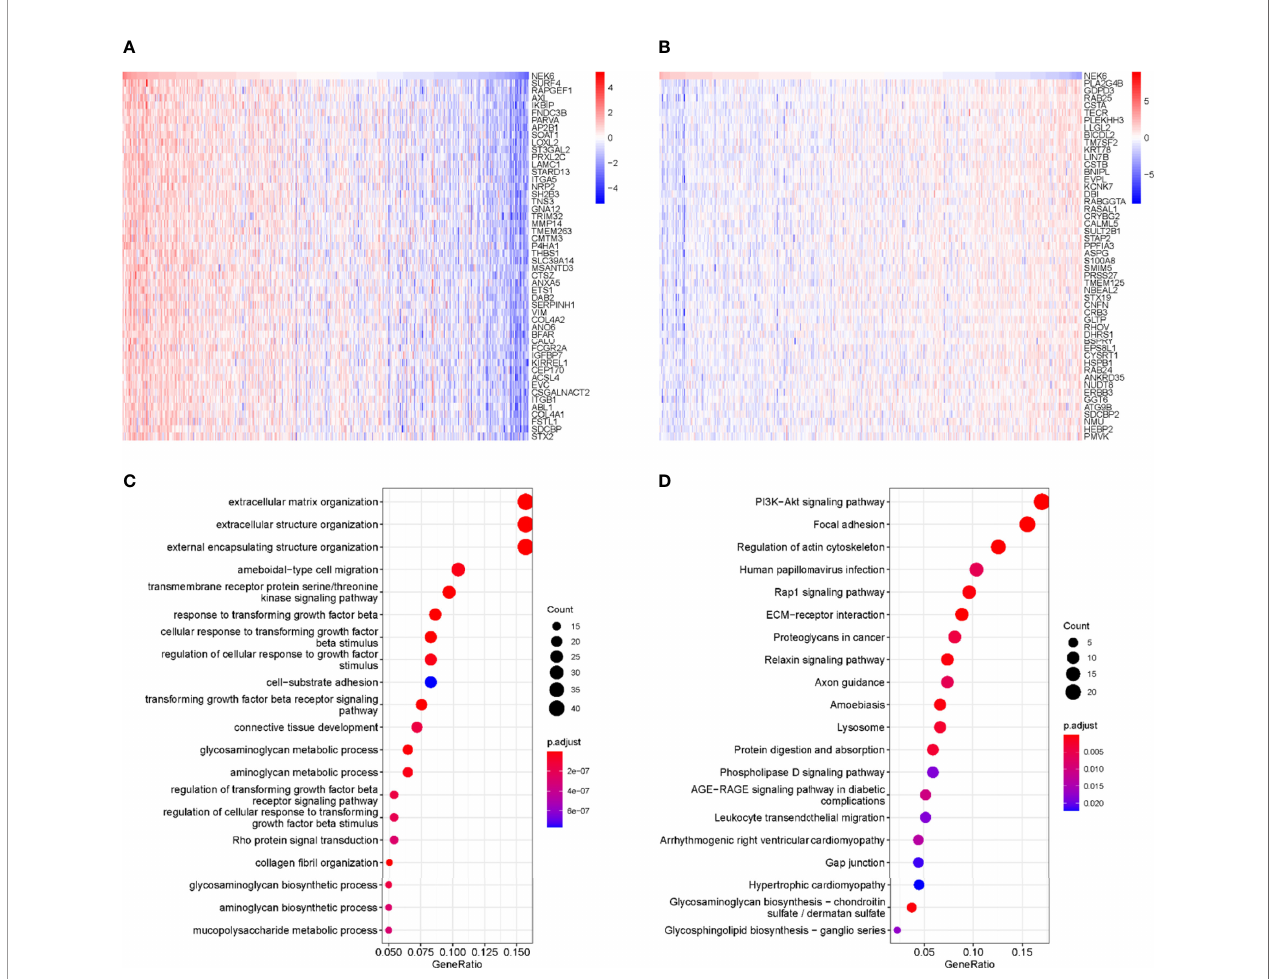
FIGURE 3 | GO and KEGG enrichment analysis of NEK6. (A) Top 50 genes negatively correlated with NEK expression levels in HNSCC. (B) Top 50 genes positively and negatively correlated with NEK expression levels in HNSCC. (C) Top 20 BP enrichment items in HNSCC. (D) Top 20 KEGG-enriched pathways in